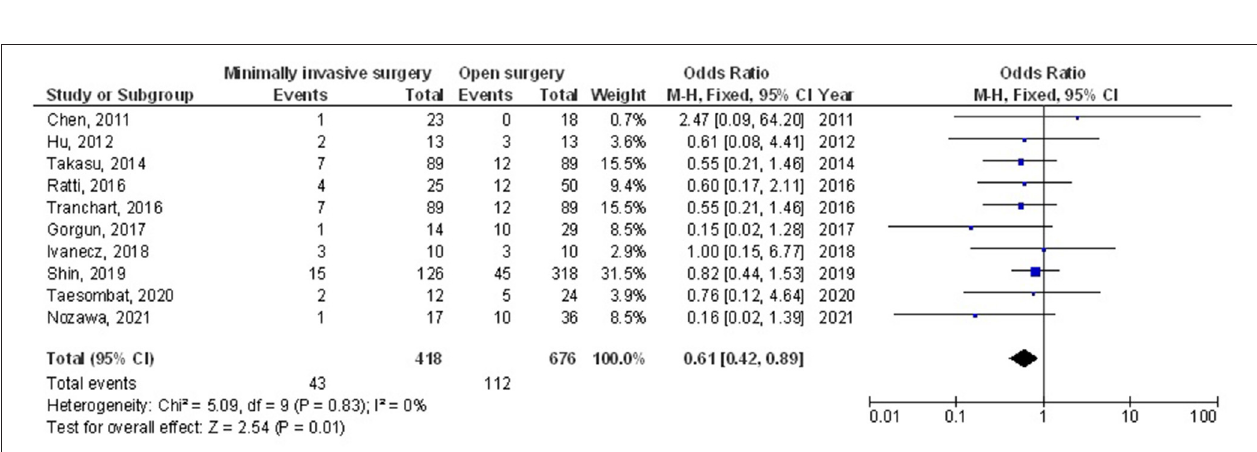
Frontiers in Surgery |